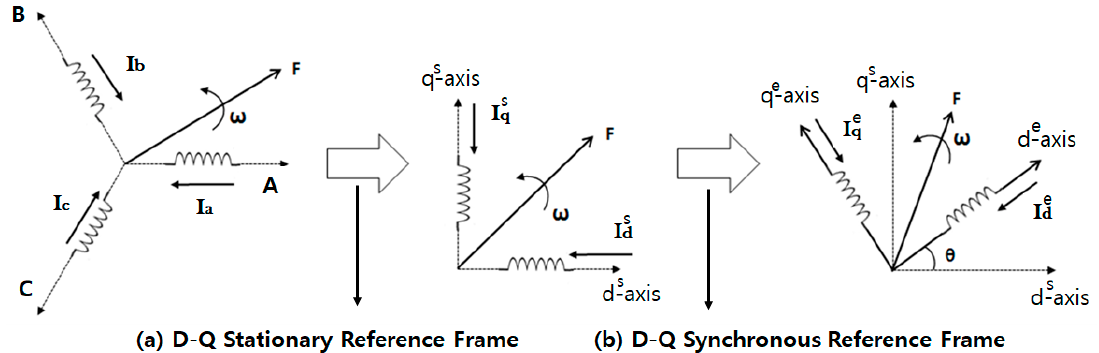
Figure 2. Direct-quadrature (D-Q) transformation process: ( a ) D-Q stationary reference frame ( b ) D- Q synchronous reference frame.